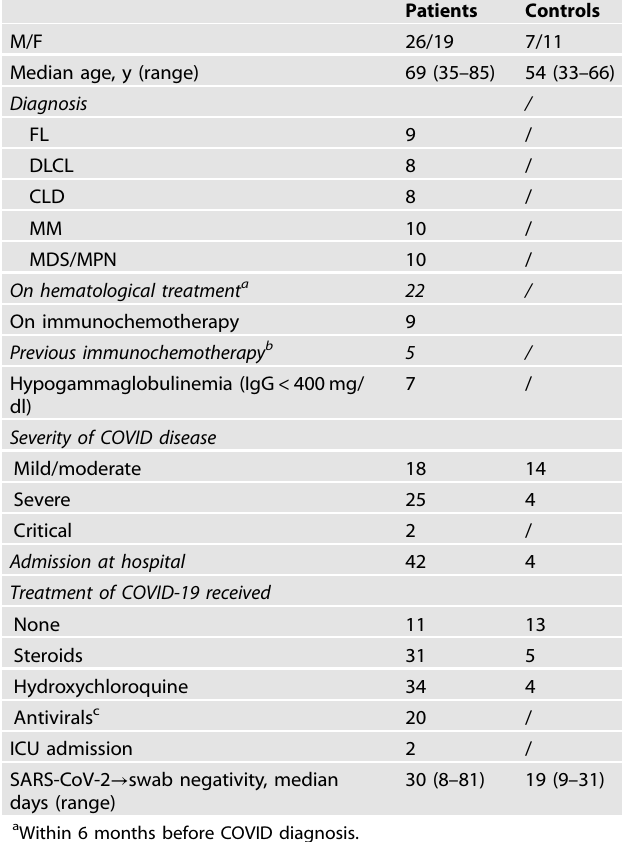
Table 1. Characteristics of patients and controls